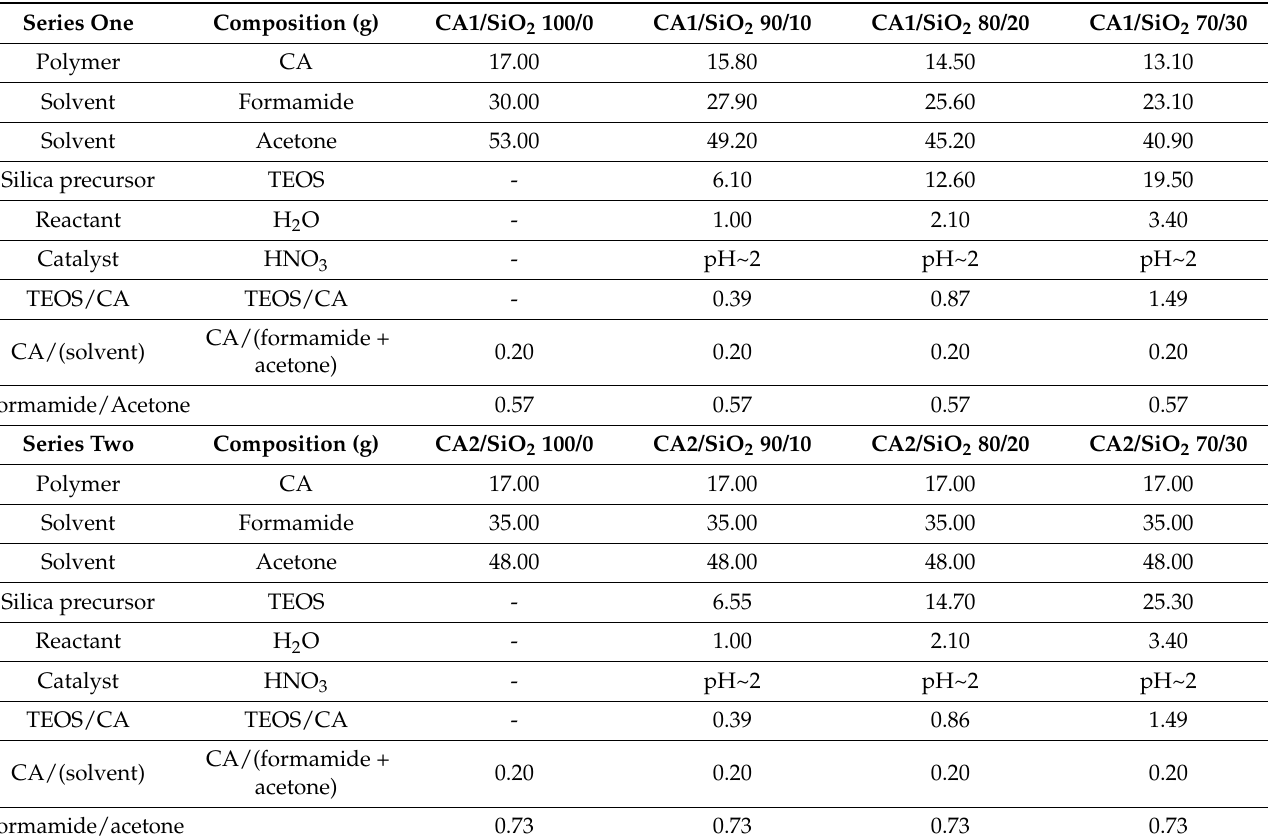
Table 1. Casting solution formulation for series one (CA1/SiO 2 ) and series two (CA2/SiO 2 ) (weight